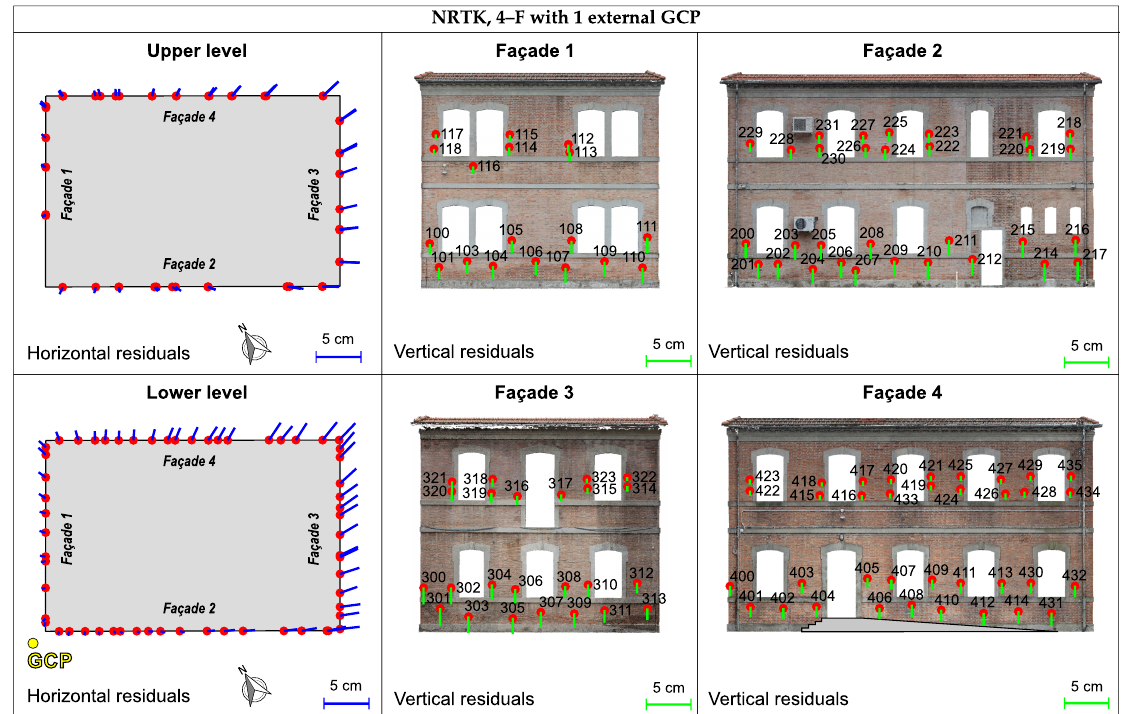
Figure A4. Horizontal and vertical residuals for NRTK image dataset processed as an overall block (4–F) with the introduction of an external GCP (shown in yellow).